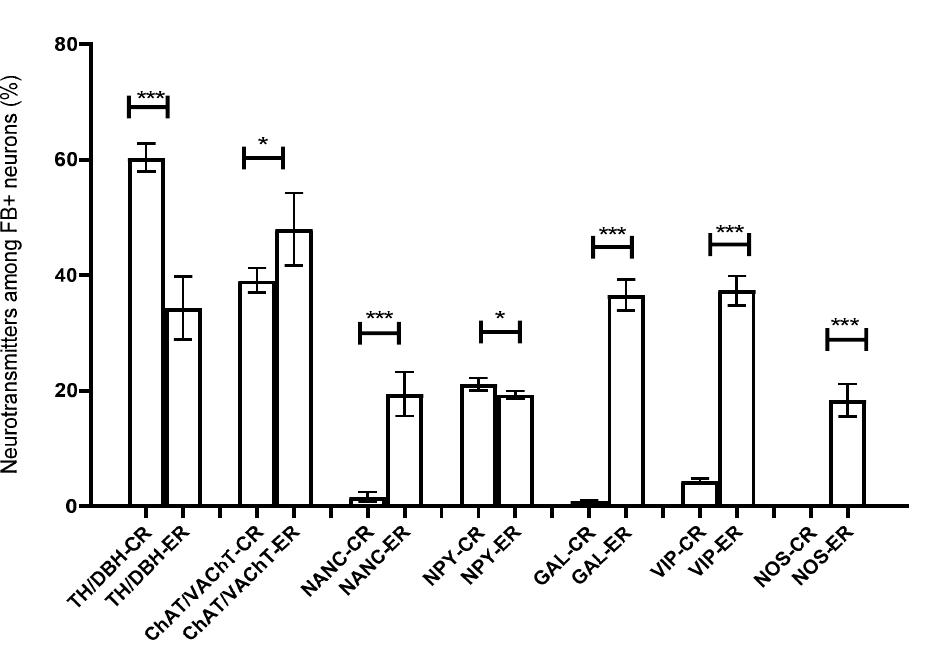
Figure 9. Percentage of FB+ neurons ( ± SEM) showing immunoreactivity against the tested substances located in the right (R) APG of the control (C) and experimental animals (E). * p < 0.05, *** p < 0.001.